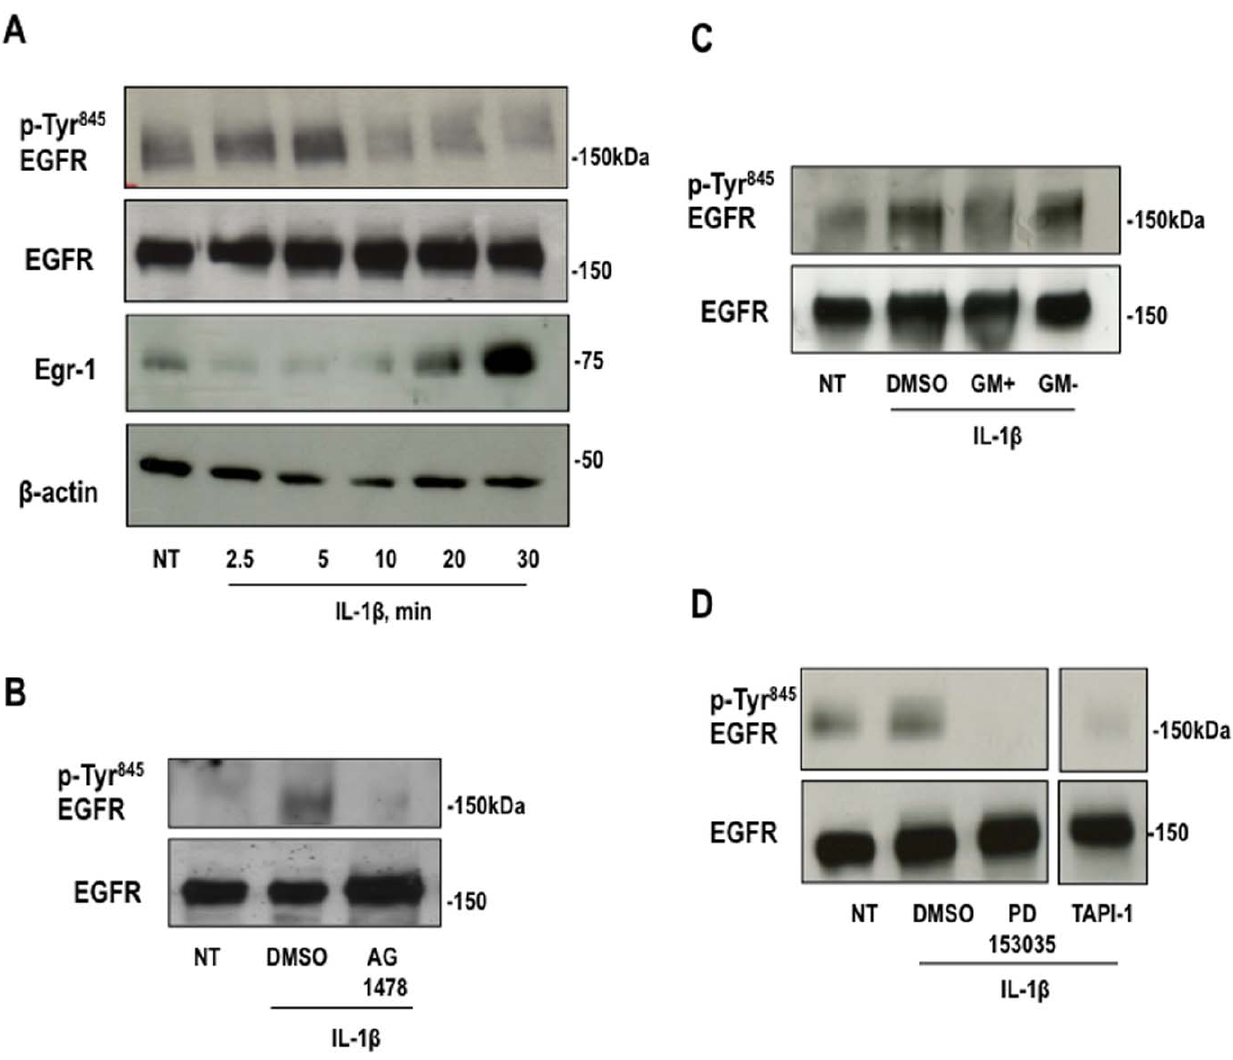
Figure 3. IL-1beta trans-activates EGFR in a time-dependent manner and it is dependent on MMP activity. ( A ) Growth-quiescent SMCs were stimulated with IL-1beta (10 ng/ml) for the indicated times. Total protein extracts were resolved by SDS-PAGE and subjected to Western blot analysis using antibodies for Egr-1, EGFR phospho-Tyr 845 , total EGFR and beta-actin. Alternatively, Western blotting for EGFR phospho-Tyr 845 or EGFR of total extracts of SMCs treated with ( B ) AG1478 (5 m M), ( C ) GM6001 + or GM6001- (25 m M) ( D ) TAPI-1 (10 m M), PD153035 (5 m M) for 30 min followed by IL-1beta stimulation for 5 min.